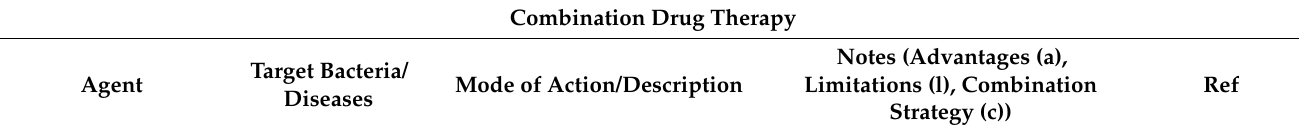
Table 6. Combination drug therapy to defeat the